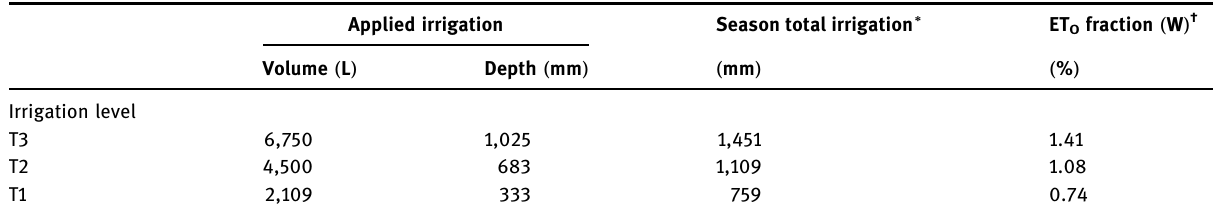
Mean area under each tree equals 6,585,170 mm 2